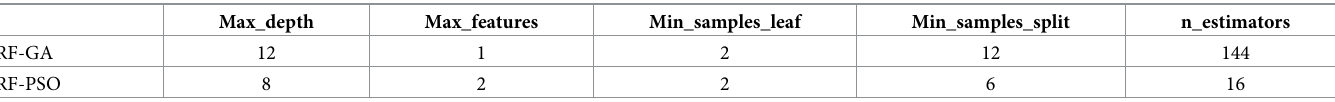
Table 4. Best parameters proposed by GA and PSO